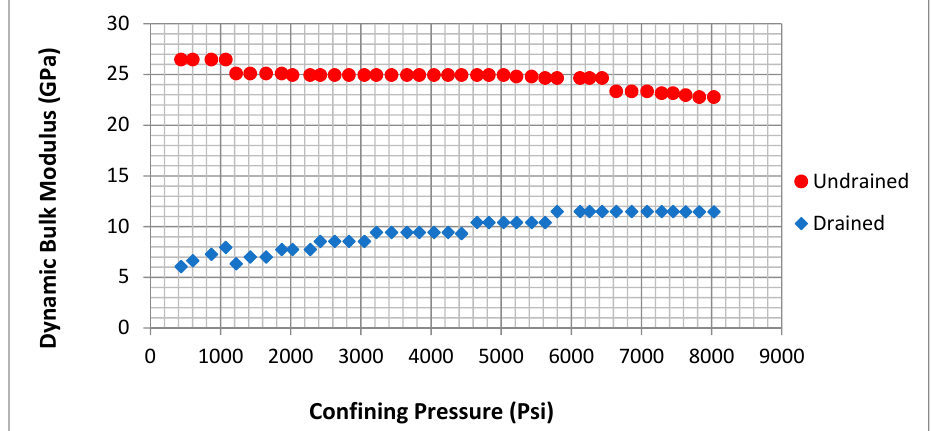
Figure 10. Undrained and drained dynamic bulk moduli vs. confining pressure for C5.